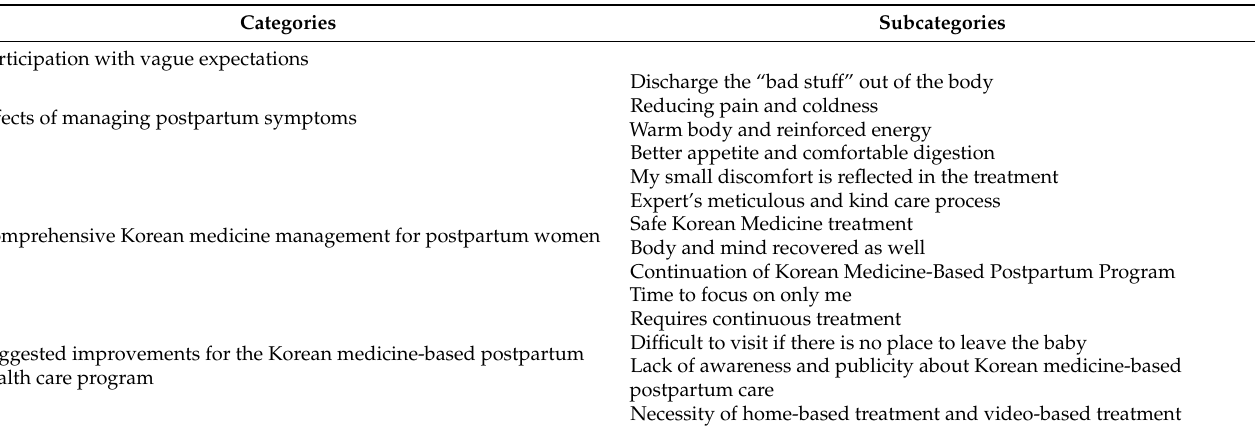
Table 3. Analysis of participants’ experience of a Korean medicine-based postpartum